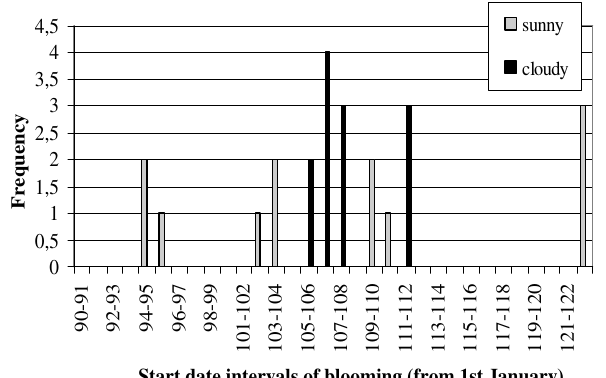
Figure 3. Distribution of the start date of sour cherry blooming at sunny and cloudy years